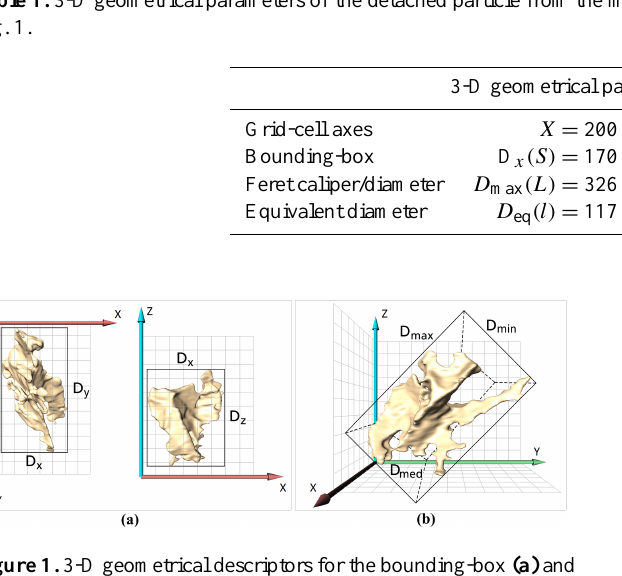
Figure 1. 3-D geometrical descriptors for the bounding-box (a) and Feret caliper (b) methods with L , l , and M corresponding to D y , D z , and D x (a) and D max , D med , and D min (b)